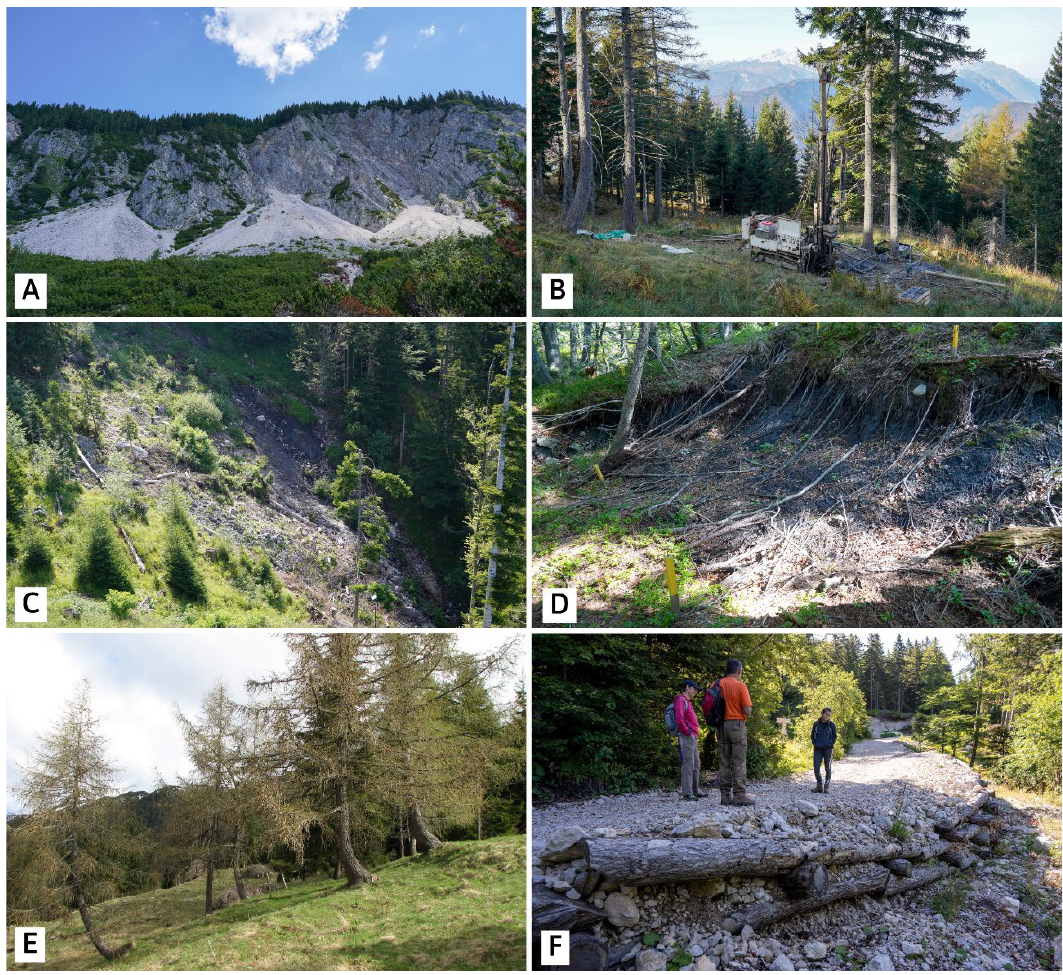
Figure 2. ( A )––Upper part of the landslide representing the area below the steep limestone slopes; ( B )––The landslide main body, consisting of the residual soil of tectonically deformed and weathered clastic rocks; ( C )––Debris flow source area as represented by the landslide toe, which is highly exposed to intensive surface erosion; ( D )––Secondary scarp near the boundary of the upper and main part of the landslide; ( E )––Curved trees indicating surface displacements; and ( F )––Mitigated deformations of the road crossing the landslide area using log cribs.